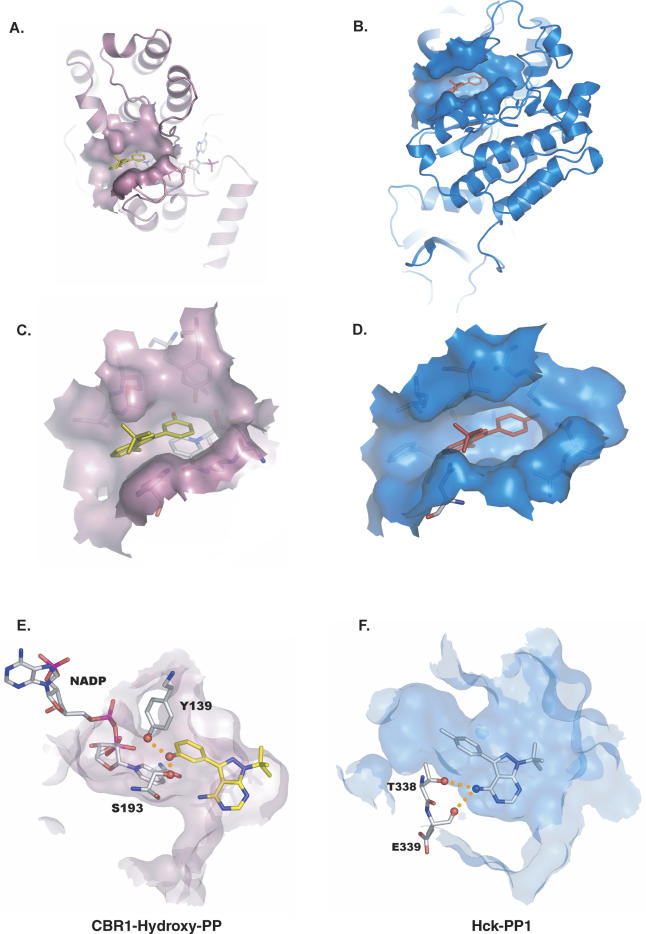
Co-Crystal Structures of CBR1–Hydroxy-PP and Hck–PP1(A, C, and E) show the binding mode of hydroxy-PP in co-crystals with CBR1. The inhibitor is oriented with its t-butyl group partially exposed to solvent and points toward the surface of the protein. The phenolic moiety of the inhibitor binds deeply within the substrate-binding pocket and makes close contacts to Ser193 and Tyr139 of the catalytic triad and the bound cofactor NADP. (B, D, and F) show the binding mode of the kinase inhibitor PP1 in complex with Hck. PP1 occupies the ATP-binding pocket as an adenosine analog. Although both protein structures show different folds (A and B), the morphology of CBR1- and Hck-binding sites are similar, and inhibitors hydroxy-PP and PP1 bind to these sites with similar shape complementarity (C and D). Key H-bond interactions between hydroxy-PP and the Ser193 and Tyr139 of CBR1 are indicated (E). The exocyclic amine of PP1 in complex with Hck makes essential H-bonds with the main-chain carbonyl oxygen of Glu339 and the side-chain oxygen of Thr338 (F). Disruption of this key H-bonding interaction by derivatization of the exocyclic amine destroys kinase affinity. The figure was prepared using the PyMol 2002 graphics system (DeLano Scientific, San Carlos, California, United States).